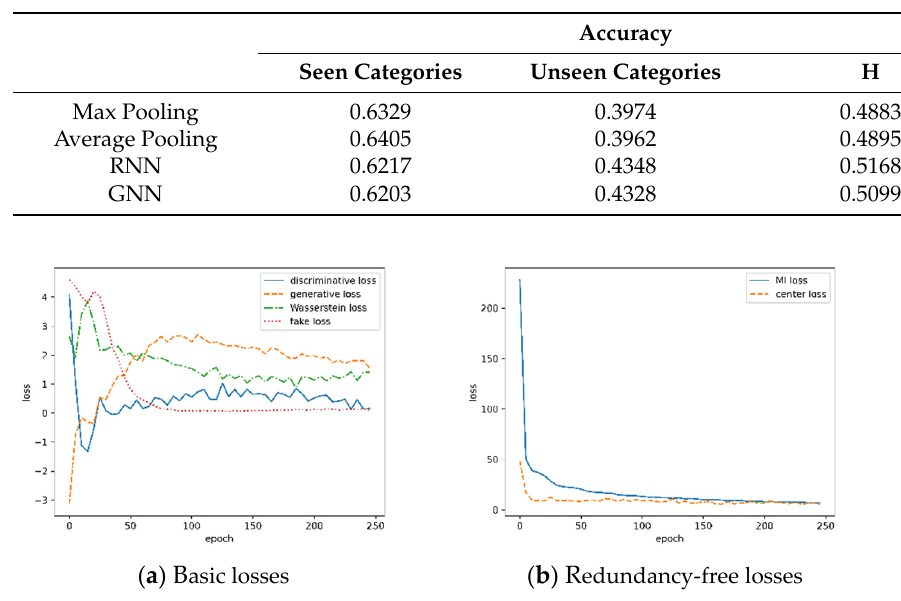
Figure 14. Training loss of MVRFFNet on the fine-grained recognition dataset.